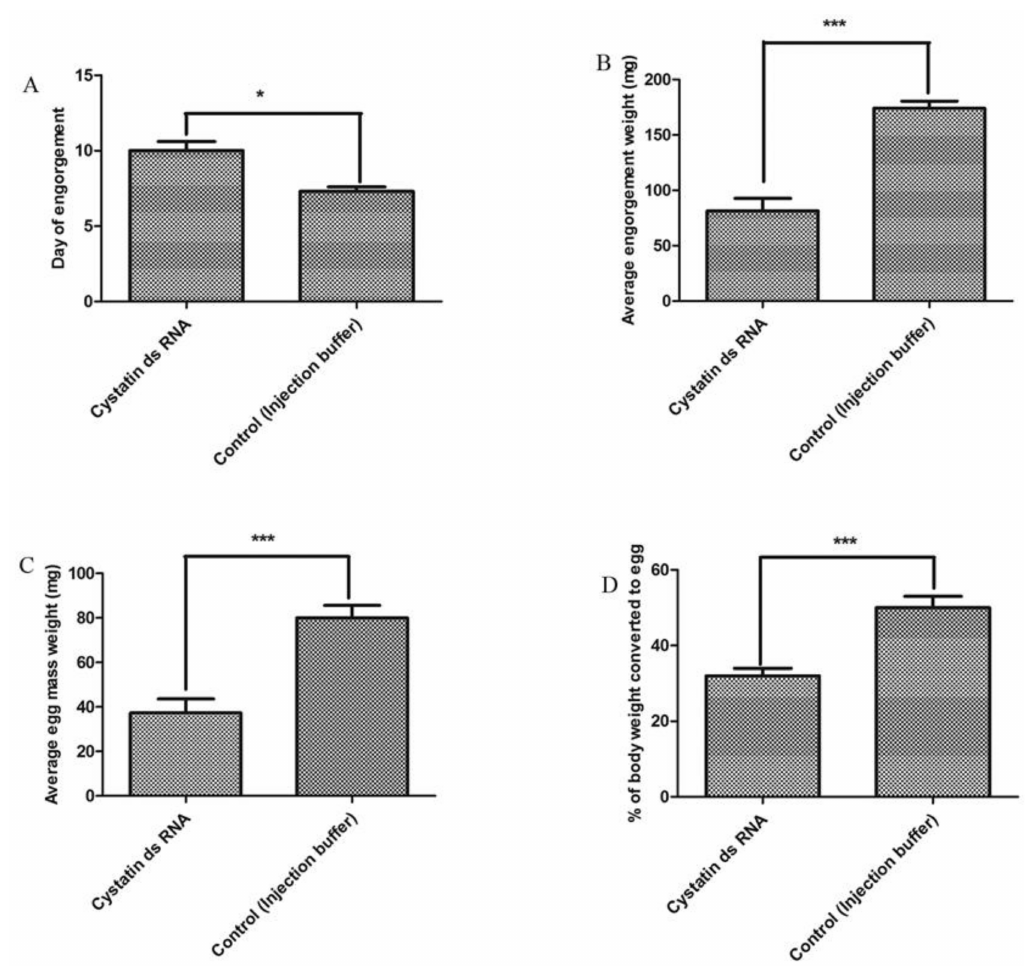
Figure 3. Knockdown effects of cystatin ds RNA on tick engorgement and reproduction. ( A ) Average days of engorgement treated by cystatin ds RNA and the control group (injection buffer); ( B ) average engorgement weight in response to cystatin ds RNA and the control group (injection buffer); ( C ) average egg mass weight in response to cystatin ds RNA and the control group (injection buffer); and ( D ) average egg conversion ratio between cystatin ds RNA and the control group (injection buffer). The asterisk (*) denotes a significant difference compared with the control group as determined by a Student’s t -test (* p < 0.028; *** p <